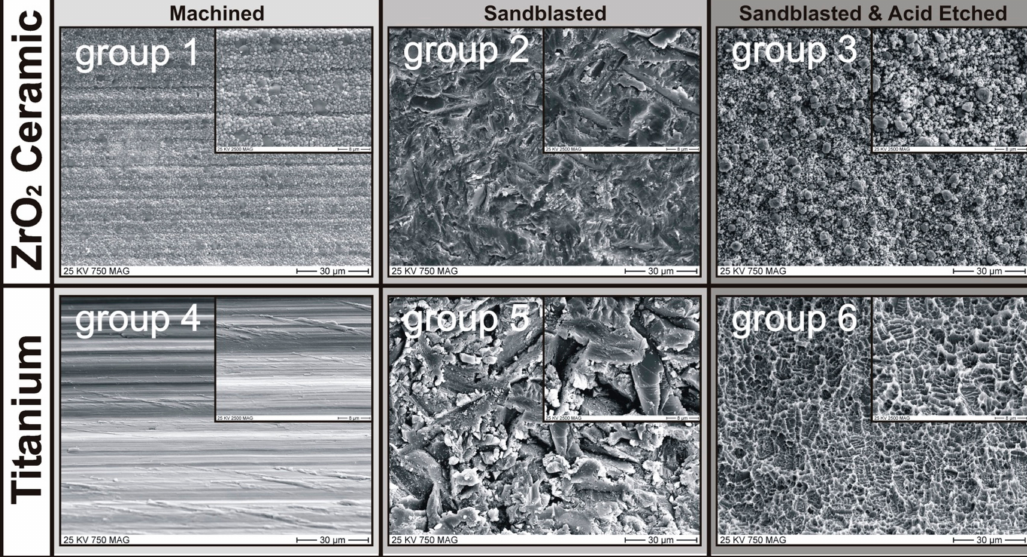
Figure 2. SEM images showing results of the di ff erent implant surface treatments. Groups 1 and 4 : nontreated machined surfaces; Groups 2 and 5 : sandblasted surfaces (corundum mesh size = 110 µ m, working pressure = 6 bar); Groups 3 and 6 : sandblasted and acid-etched surfaces (result: